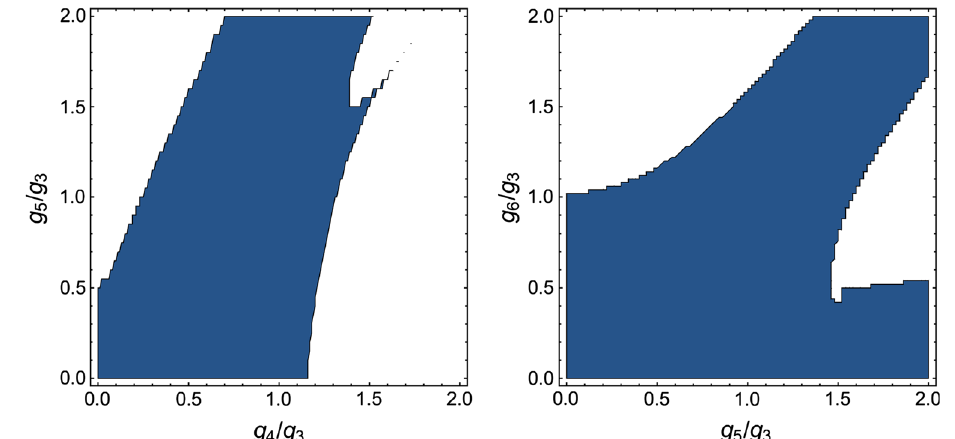
Fig. 3 Plots of the existence of an attractive non-trivial UV fixed point or loses its attractiveness. In both systems the area where the fixed point exists is rather large and contains the identification g n > n (blue) dependent on the higher couplings. Left: The system (μ,λ 3 , g 3 ) [3] dependent on the higher couplings g 4 and g 5 . Right: The system veniently, the area increases for the better truncation, indicating that the (μ,λ ,λ , g , g ) dependent on the higher couplings g system becomes more stable with an improvement of the truncation. 3 4 3 4 5 and g 6 . The The number of attractive directions is uniformly two in the left panel higher couplings λ n > n are always identified with λ 3 . The blue area max and three in the right marks the region where an attractive UV fixed point was found. At the border of this area the fixed point either vanishes into the complex plane